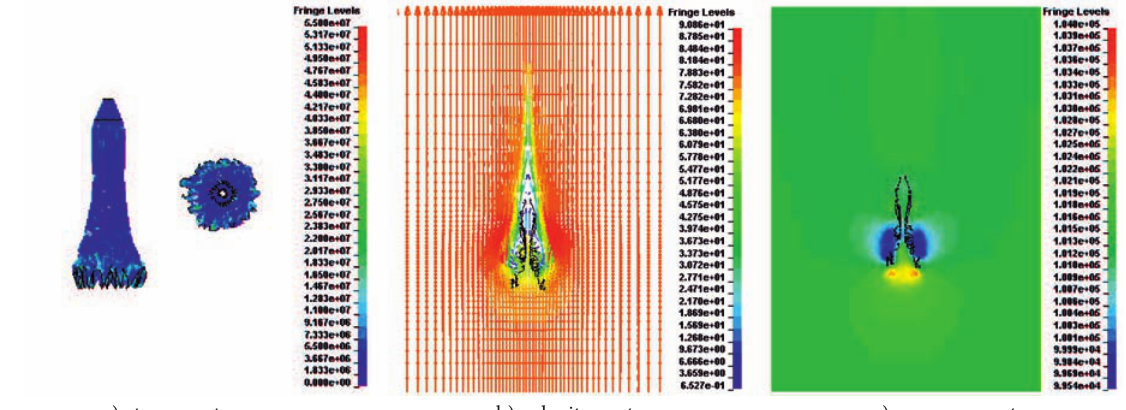
Fig. 3. Structural an d flow fie ld results a t t = 0.048